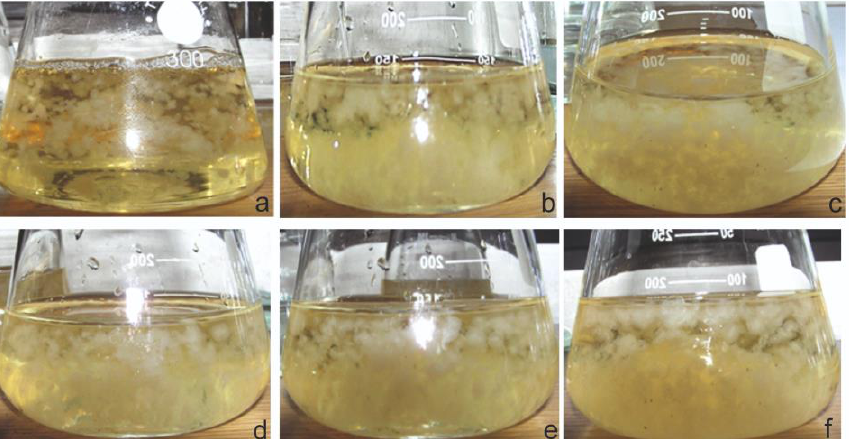
Figure 1. Examples of the morphological appearance of Ganodema applanatum control ( a ), and experimental mycelial cultures after 10 days of elicitation. Used concentrations of elicitors: ( b ) 10 µM; ( c ) 50 μM; ( d ) 100 μM; ( e ) 150 μM; ( f ) 200 μM.